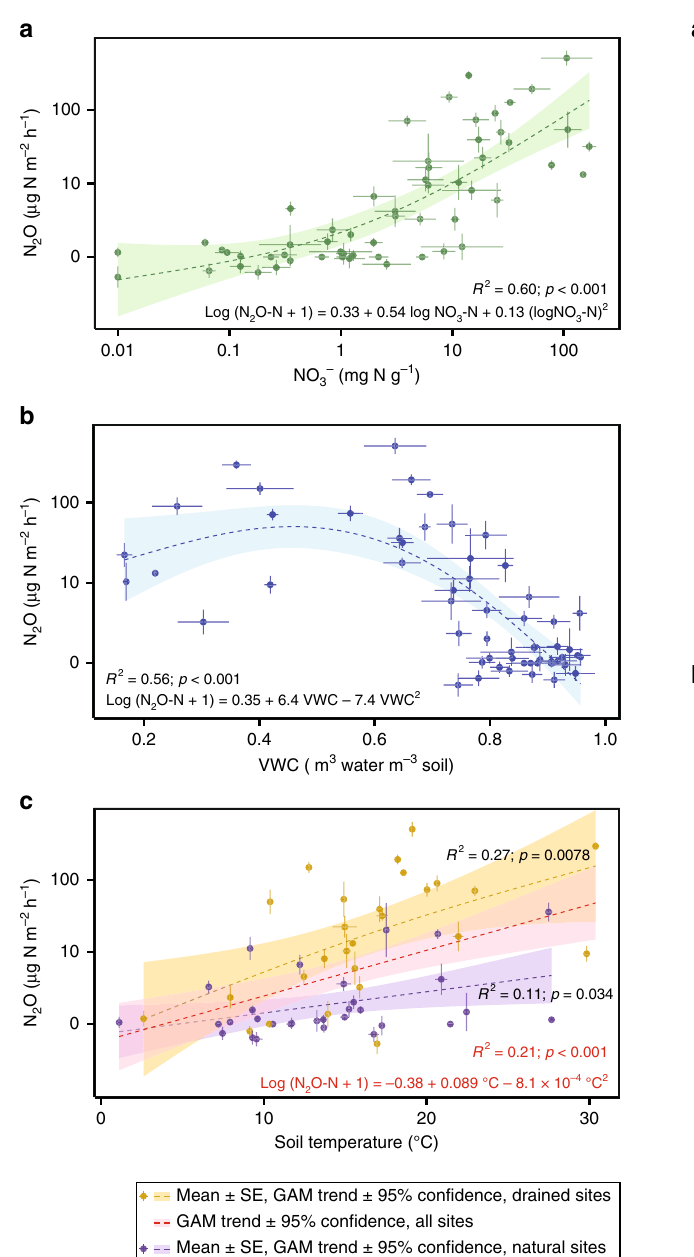
Fig. 3 Relationships between site-mean N 2 O fl uxes and soil parameters. The panels correspond to the relationships between N 2 O fl uxes and: a nitrate; b volumetric water content; c soil temperature at 40 cm depth across all sites, and drained and natural sites. The error bars correspond to standard errors of the mean (s.e.m.). N = 58